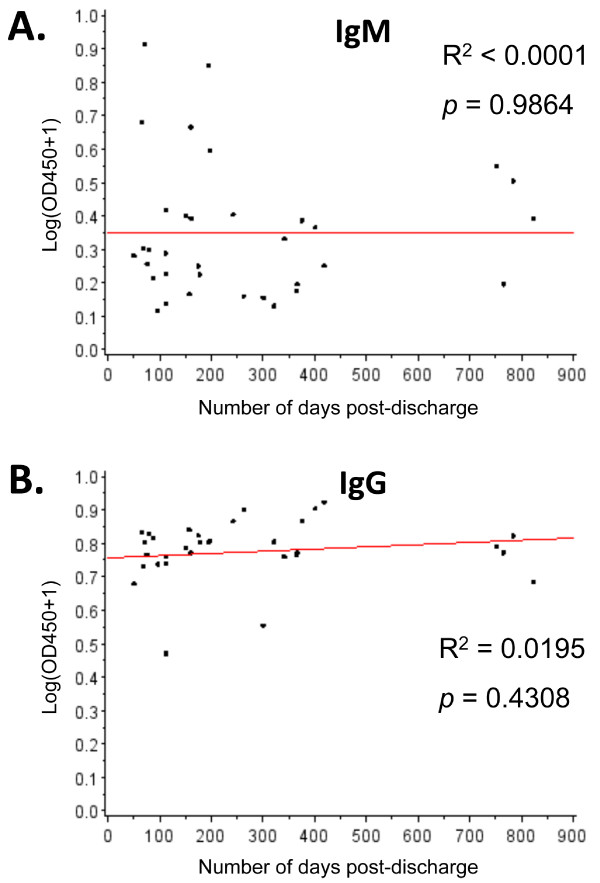
Regression analysis for IgM and IgG responses against number of days post-discharge for convalescent LF patients. Corrected mean OD450 values for LASV-specific IgM (A.) and IgG (B.) levels in LF convalescent patients did not reveal any dependence with time post-discharge for immunoglobulins responses. Hypothesis tests for the slope of each regression line revealed zero slopes for both profiles, suggesting that IgM and IgG responses for convalescent patients remained relatively constant after discharge. The fitted intercept for the regression line shown in (A.) was 0.46 (SE = 0.09), which showed prolonged elevation in IgM responses for convalescent LF patients. The fitted intercept of 1.14 (SE = 0.06) for (B.) was indicative of a prolonged mature humoral response (IgG) in convalescent LF patients.